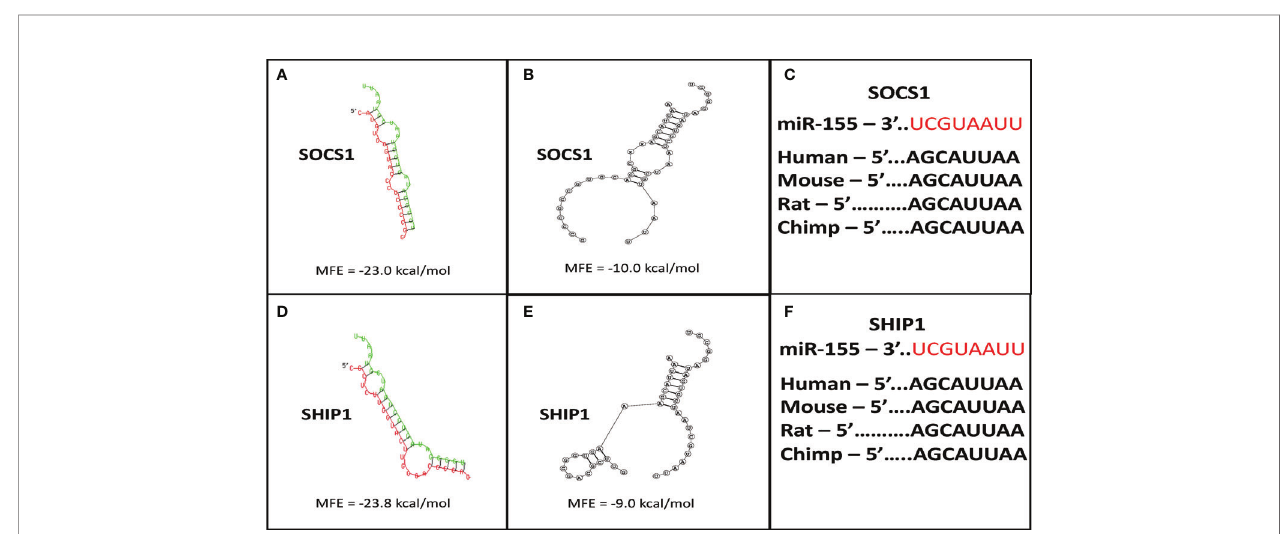
FIGURE 3 | Suppressor of cytokine signaling 1 (SOCS1) and SH-2 containing inositol 5 ’ -polyphosphatase 1 (SHIP1) are targets of miR-155. Target prediction in silico analysis was performed for fi nding the minimum free energy hybridization of a long and a short RNA to predict miR-155 targets. Analysis of the structural binding between miR-155 and SOCS1 or SHIP1 was conducted using the RNAhybrid and Bifold softwares. TargetScan software analysis was also performed to determine whether the binding sequences between miR-155 and SOCS1 or SHIP1 are conserved among multiple species. (A) RNA hybrid representative structural binding ef fi ciency and minimum free energy between miR-155 and SOCS1. (B) RNA bifold representative structural binding ef fi ciency for the minimum hybrid free energy conformation between miR-155 and SOCS1. (C) Target sequence conservation of miR-155 to SOCS1 3 ’ UTR in multiple mammalian species. (D) RNA hybrid representative structural binding ef fi ciency and minimum free energy between miR-155 and SHIP1. (E) RNA bifold representative structural binding ef fi ciency for the minimum hybrid free energy conformation between miR-155 and SHIP1. (F) Target sequence conservation of miR-155 to SHIP1 3 ’ UTR in multiple mammalian species. Values in the quadrants depict minimum free